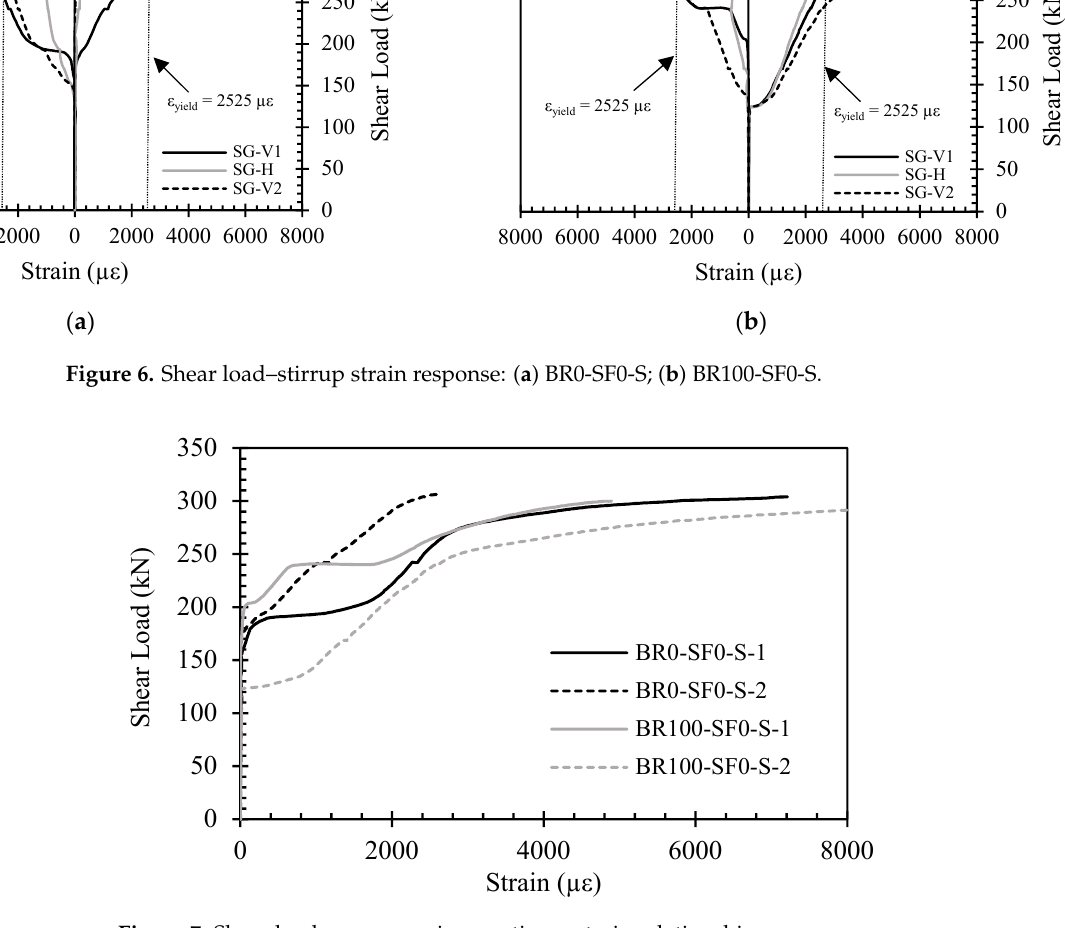
Figure 7. Shear load versus maximum stirrup strain relationships.